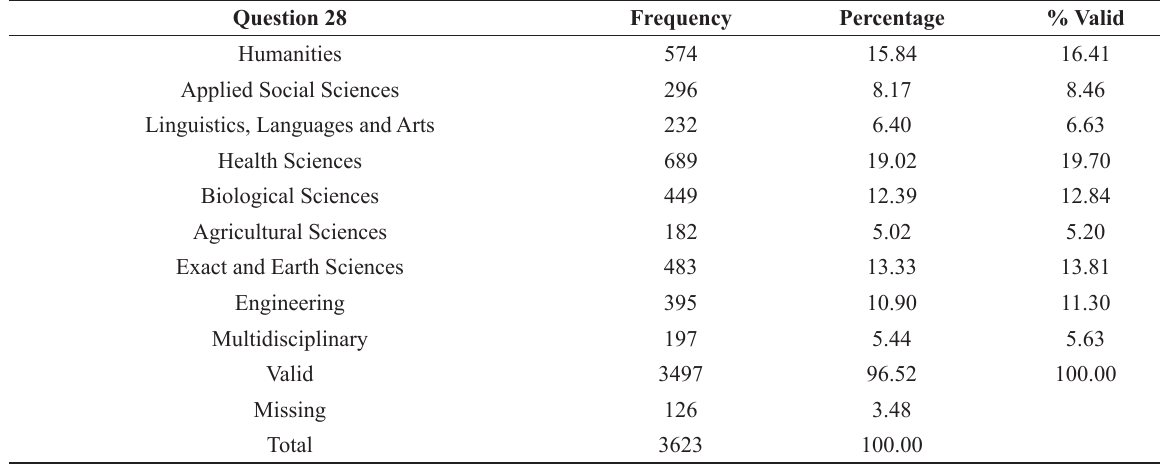
Participants in the study as per area of